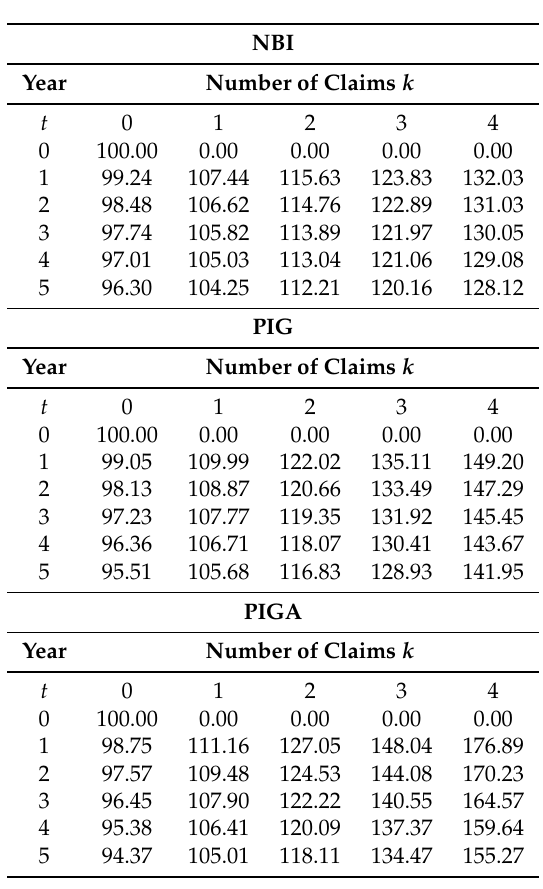
A Posteriori, or Bonus-Malus, premiums for risk class 3, regression models with varying dispersion.